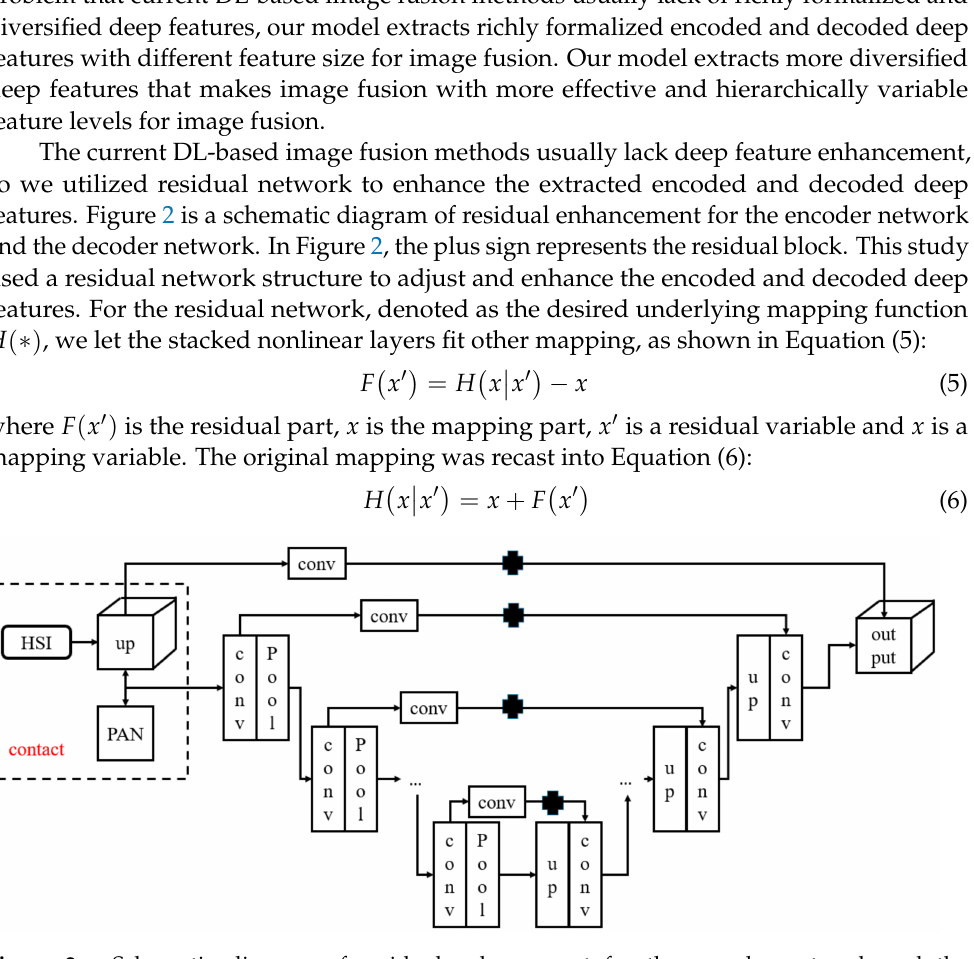
Figure 2. Schematic diagram of residual enhancement for the encoder network and the decoder